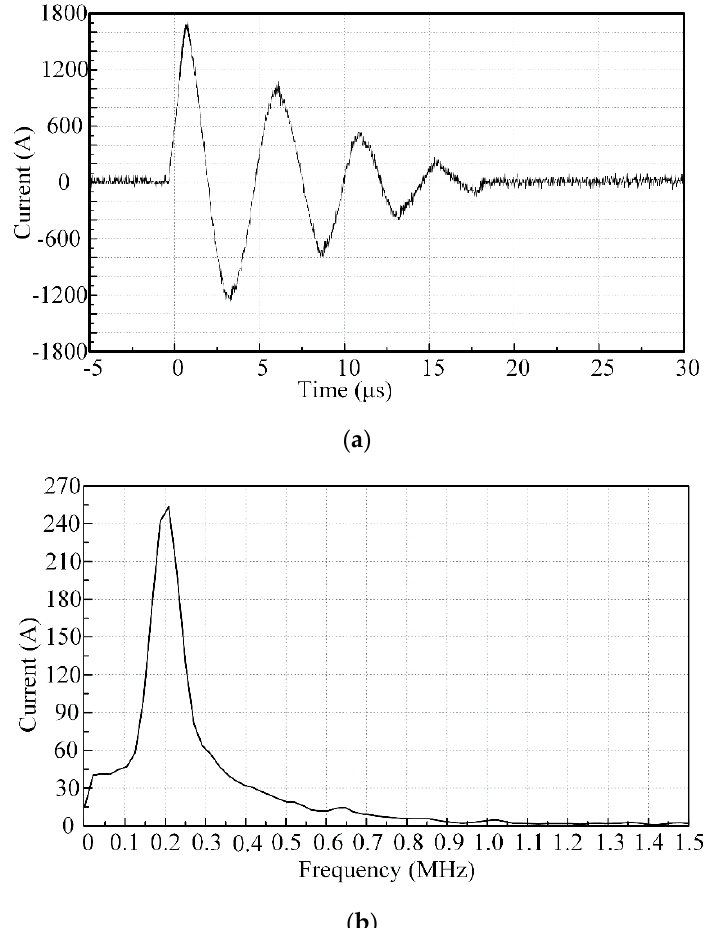
Figure 8. The characteristics of the received current in the excitation coil. ( a ) Time domain diagram of current; ( b ) frequency domain diagram of current.